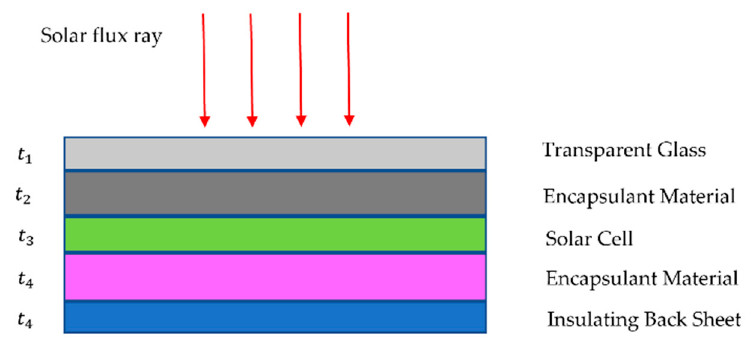
Figure 1. PV module layered structure with perpendicular solar flux beams.